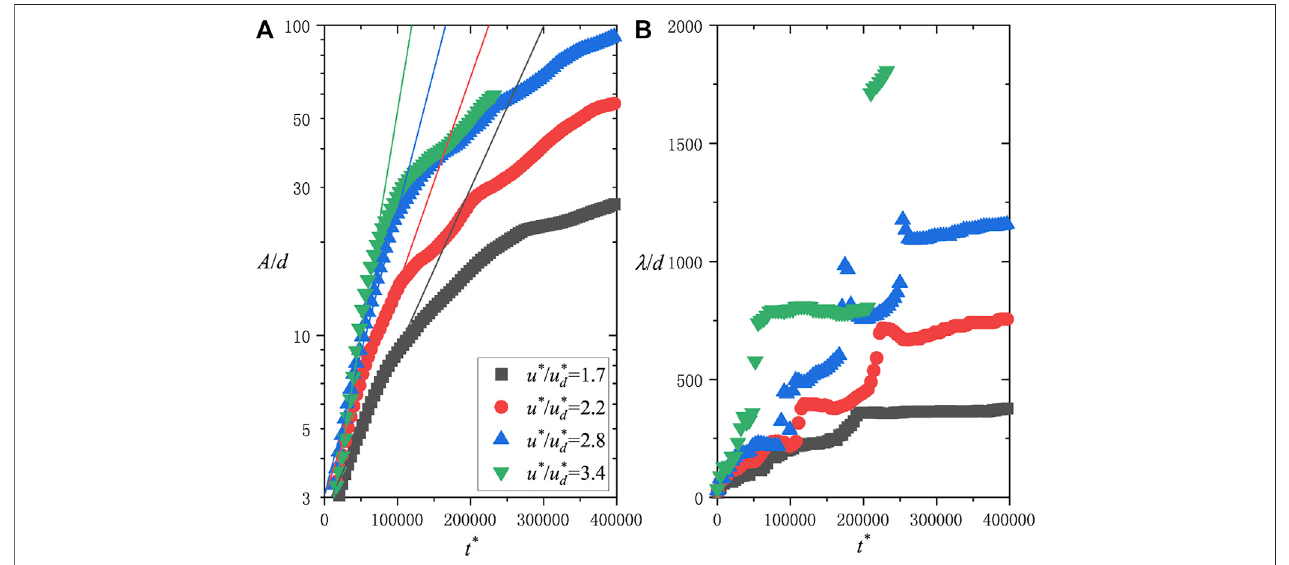
FIGURE 6 | Time evolution of ripple amplitude (A) and wavelength (B) from the fl at bed. Solid lines in (A) indicate the linear stage of ripple formation.